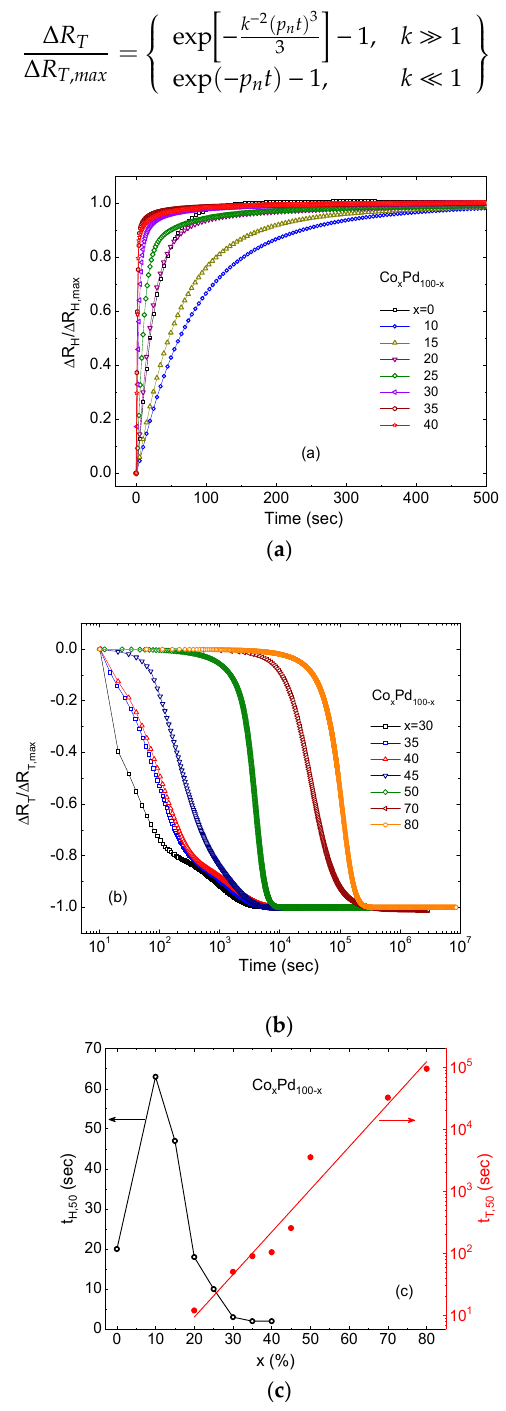
Figure 3. Time dependence of the normalized resistance changes due to hydride formation ∆(cid:3019) (cid:3257) ∆ R ( b ) of 15 nm thick Co x Pd 100-x alloys with different Co content x. ( c ) The and thickness expansion ∆(cid:3019) (cid:3269) T ∆ and thickness expansion ( b ) of 15 nm thick Co x Pd 100-x alloys with di ff erent Co content x. ( c ) The ∆(cid:3019) (cid:3269),(cid:3288)(cid:3276)(cid:3299) R T , max half-time of hydride formation 𝑡 (cid:3009),(cid:2873)(cid:2868) (left vertical axis) and of thickness expansion 𝑡 (cid:3021),(cid:2873)(cid:2868) (right vertical half-time of hydride formation t H ,50 (left vertical axis) and of thickness expansion t T ,50 (right vertical axis) as a function of Co concentration x. Lines are guides for the eye. axis) as a function of Co concentration x. Lines are guides for the